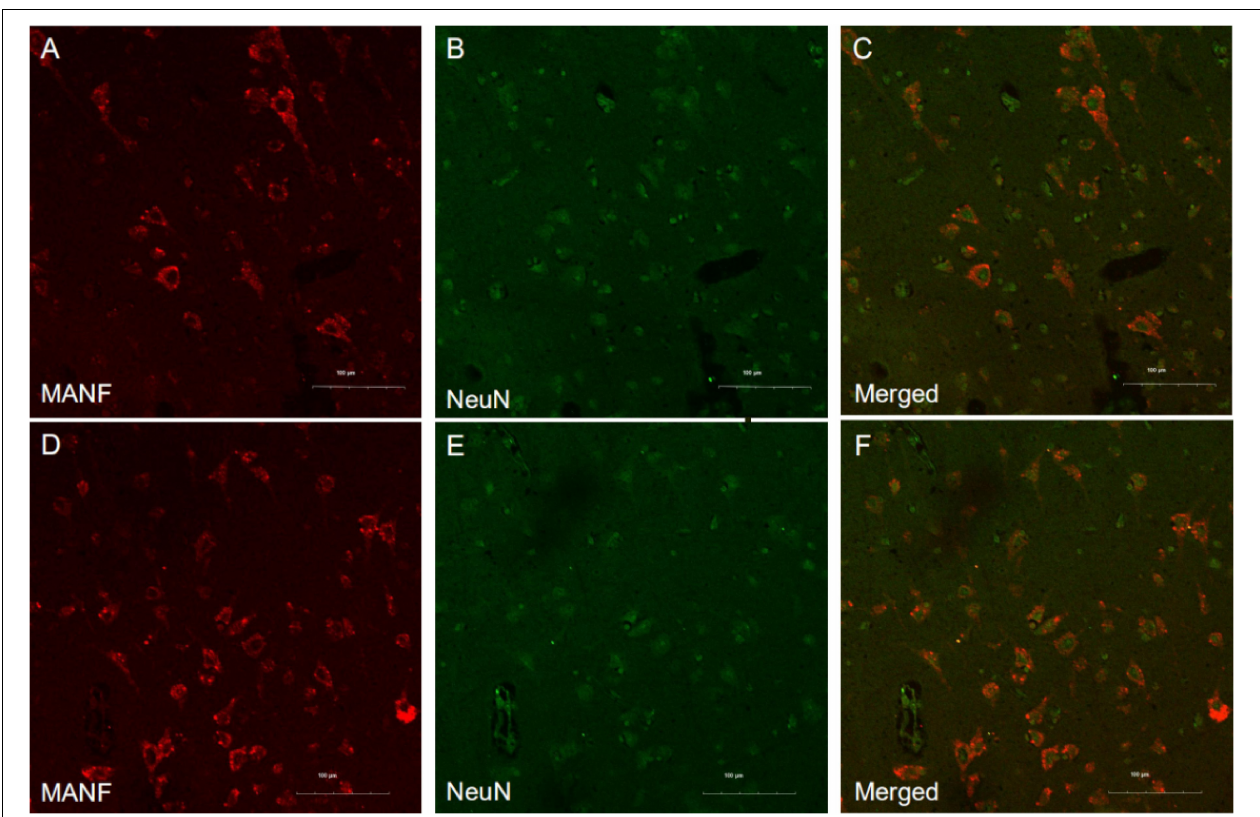
FIGURE 6 | Representative images of MANF and NeuN expression in the ITGC. (A–F) Representative micrographs of double immunolabeling with antibodies against MANF (red) and NeuN (green). MANF was mainly detected in neurons. Scale bar: 100 µ m (A–F)